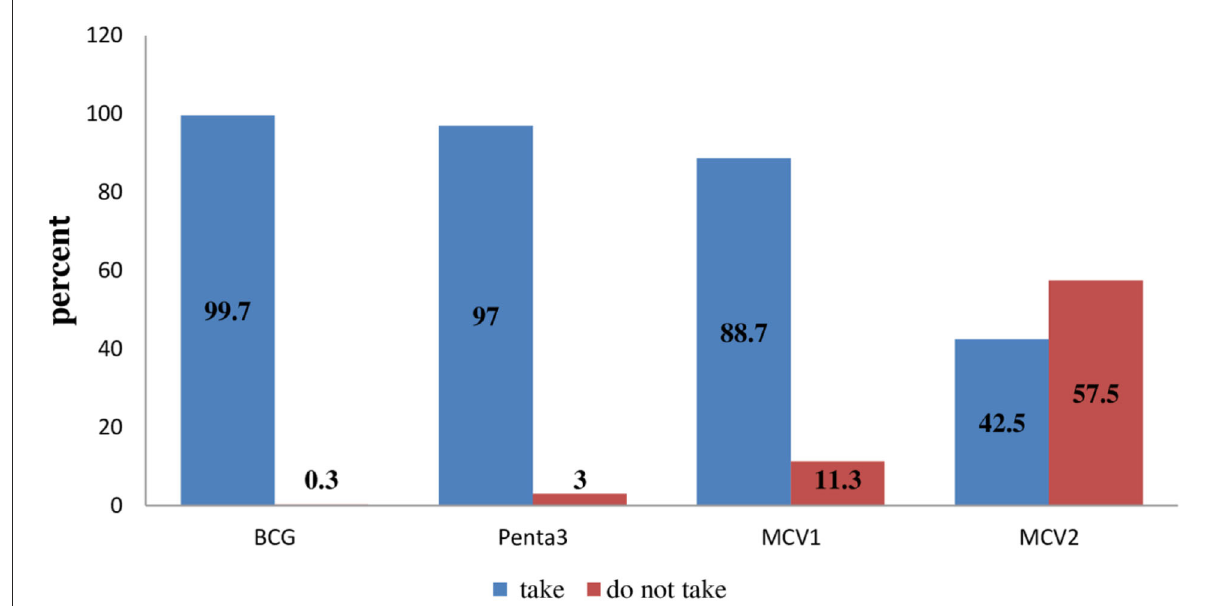
FIGURE1 The level of MCV2 among children in urban areas of North Shoa Zone, Oromia Region,